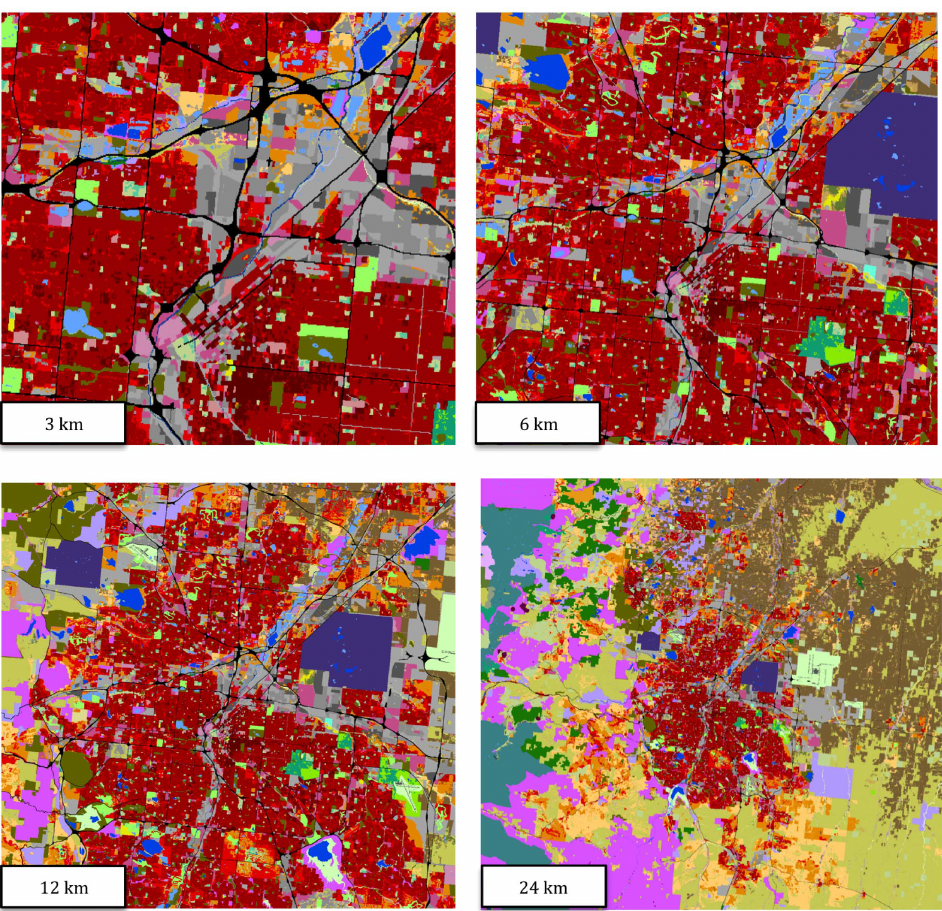
Figure 6. The National Land Use dataset for 2010 centered on Denver, Colorado (I-25 and I-70), showing NLUD at 4 different scales. Detailed industrial (light grey), commercial (dark grey), and transportation (black) land uses can be readily scene in the detailed map (3 km scale), while regional land use patterns surrounding the Denver metro area, including ‘‘open space’’ lands composed of recreational, conservation, and production lands, are shown in the coarse map (24 km scale). The full legend is provided in Figure 4.